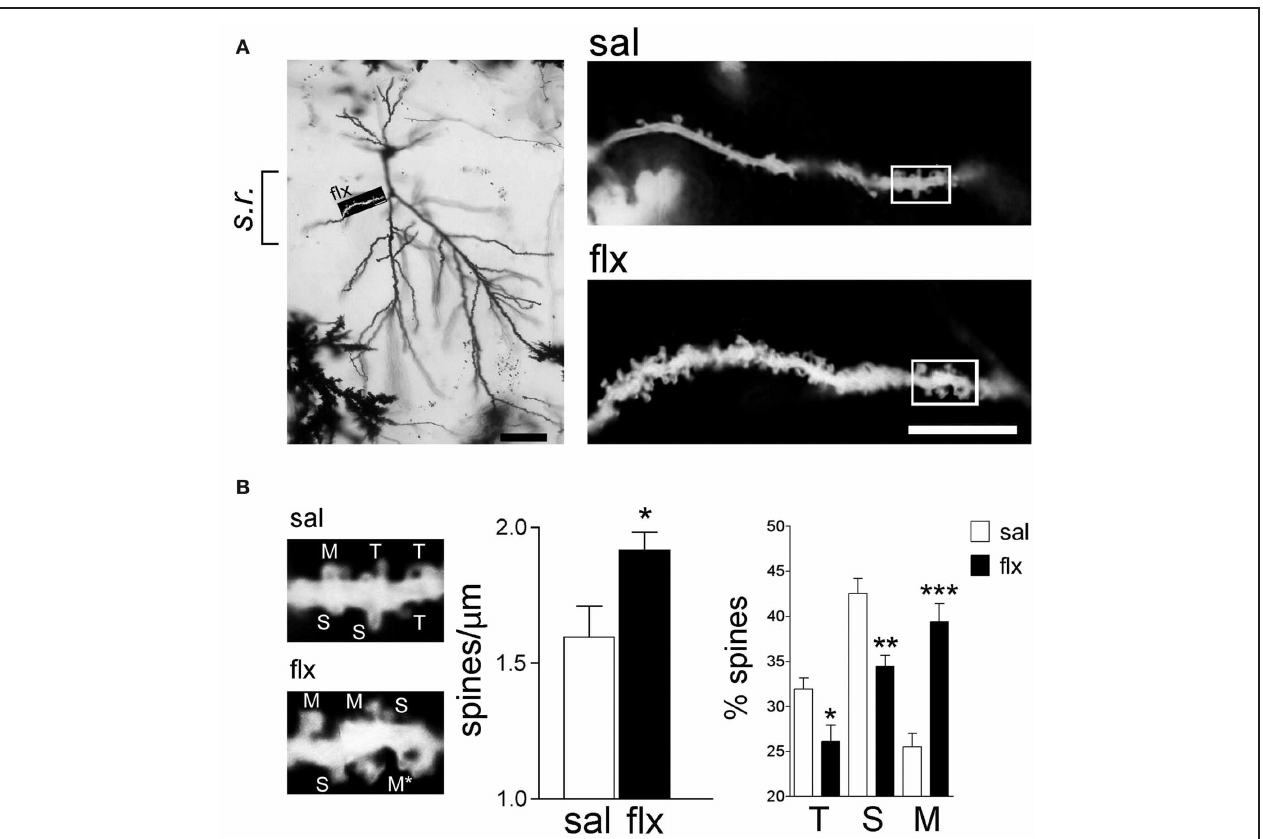
mushroom/branched (M). The asterisks indicate two superimposed M-type spines that were resolved by observation at different focal planes. Bar graphs show spine density and the abundance of spines in each of the three shape categories. Results are presented as mean ± SEM and were determined from 11 cells per condition, obtained from eight saline (total spines, 874)- and nine fluoxetine (total spines, 957)-treated rats. Data were statistically evaluated with the Mann–Whitney U -test, ∗ p < 0 . 05, ∗∗ p < 0 . 01, ∗∗∗ p < 0 .